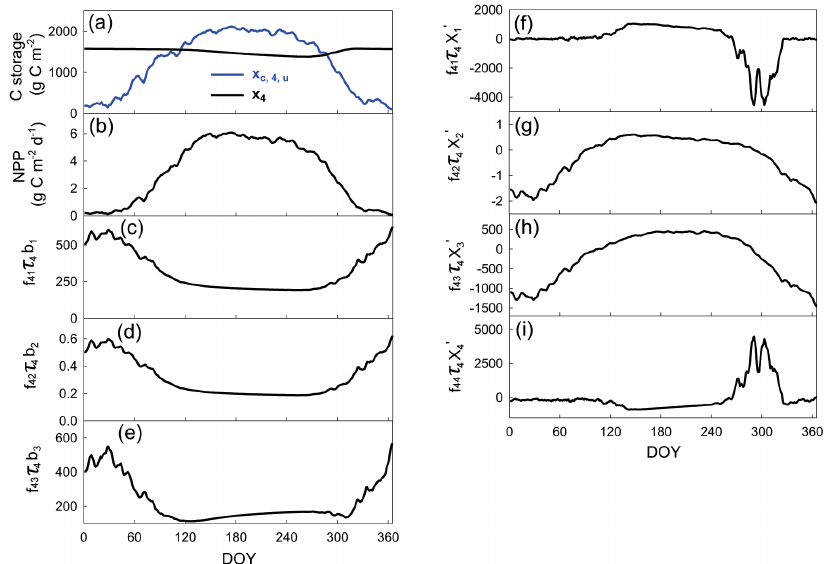
n P f 4 j τ 4 x (cid:48) (t) in panels (f–i) for litter. j j = 1 ,j (cid:54)= 4